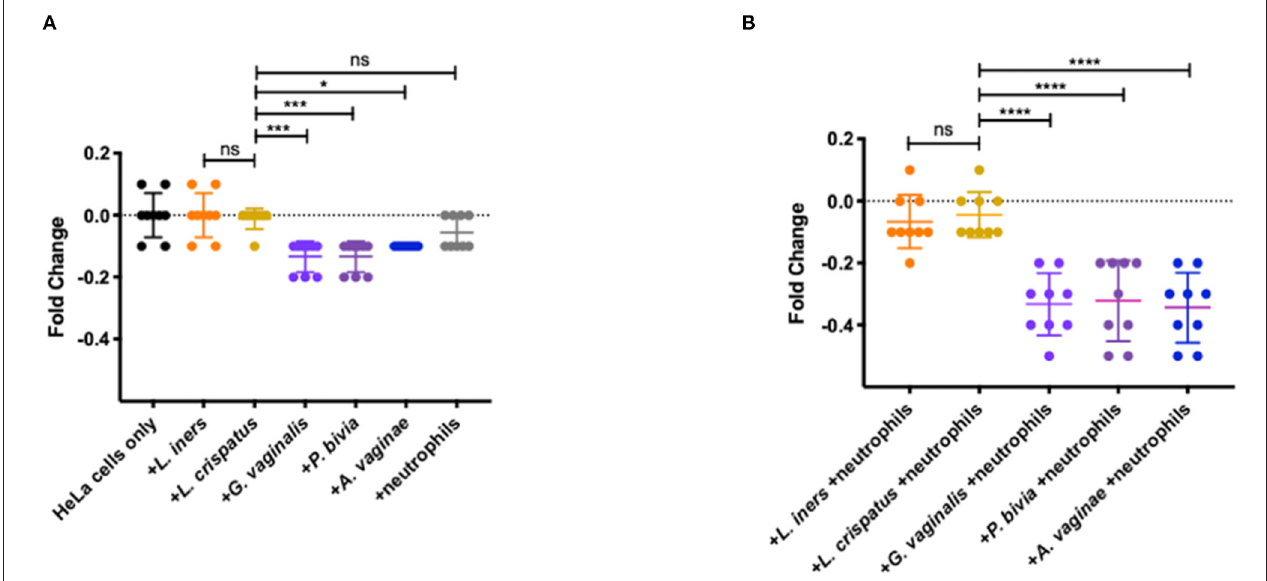
FIGURE 4 | Effects of vaginal bacteria and neutrophils on HeLa cells using a TEER breakdown assay. (A) Fold change from baseline of TEER breakdown assay in the presence of neutrophils or vaginal bacteria. No significant differences in TEER values in wells containing neutrophils and wells containing L. crispatus ( p = 0.2773, represented as ns in figure) nor in wells containing L. iners and L. crispatus ( p = 0. 9993, represented as ns in figure). Significant decrease in fold change in wells containing the BV associated bacteria: G. vaginalis, P. bivia, and A. vaginae when compared to wells containing L. crispatus ( p = 0.0001, p = 0.0001, and p = 0.0104, respectively, represented as ****, ***, and * in figure). (B) Fold change from baseline of TEER breakdown assay in the presence of neutrophils and vaginal bacteria. No significant difference between wells containing neutrophils and two different Lactobacillus species ( p = 0.9904, represented as ns in figure). Significant decrease in fold change in TEER value in wells containing neutrophils and G. vaginalis or P. bivia or A. vaginae compared to co-cultures containing neutrophils and L. crispatus ( p < 0.0001, p < 0.0001, and p < 0.0001, all represented in figure as ****). Statistical differences in TEER values between experimental conditions were determined by ANOVA with a p -value < 0.05 considered significant. Lines represent mean and